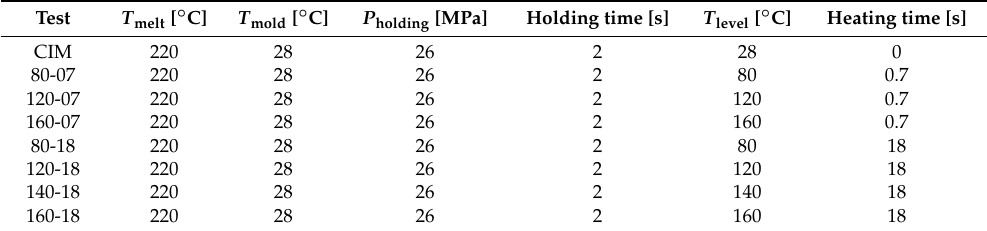
Table 1. Operative injection molding conditions ( T melt = melt temperature; T mold = mold temperature; P holding = holding pressure; T level = temperature reached on the cavity surface thanks to the activation of the heating